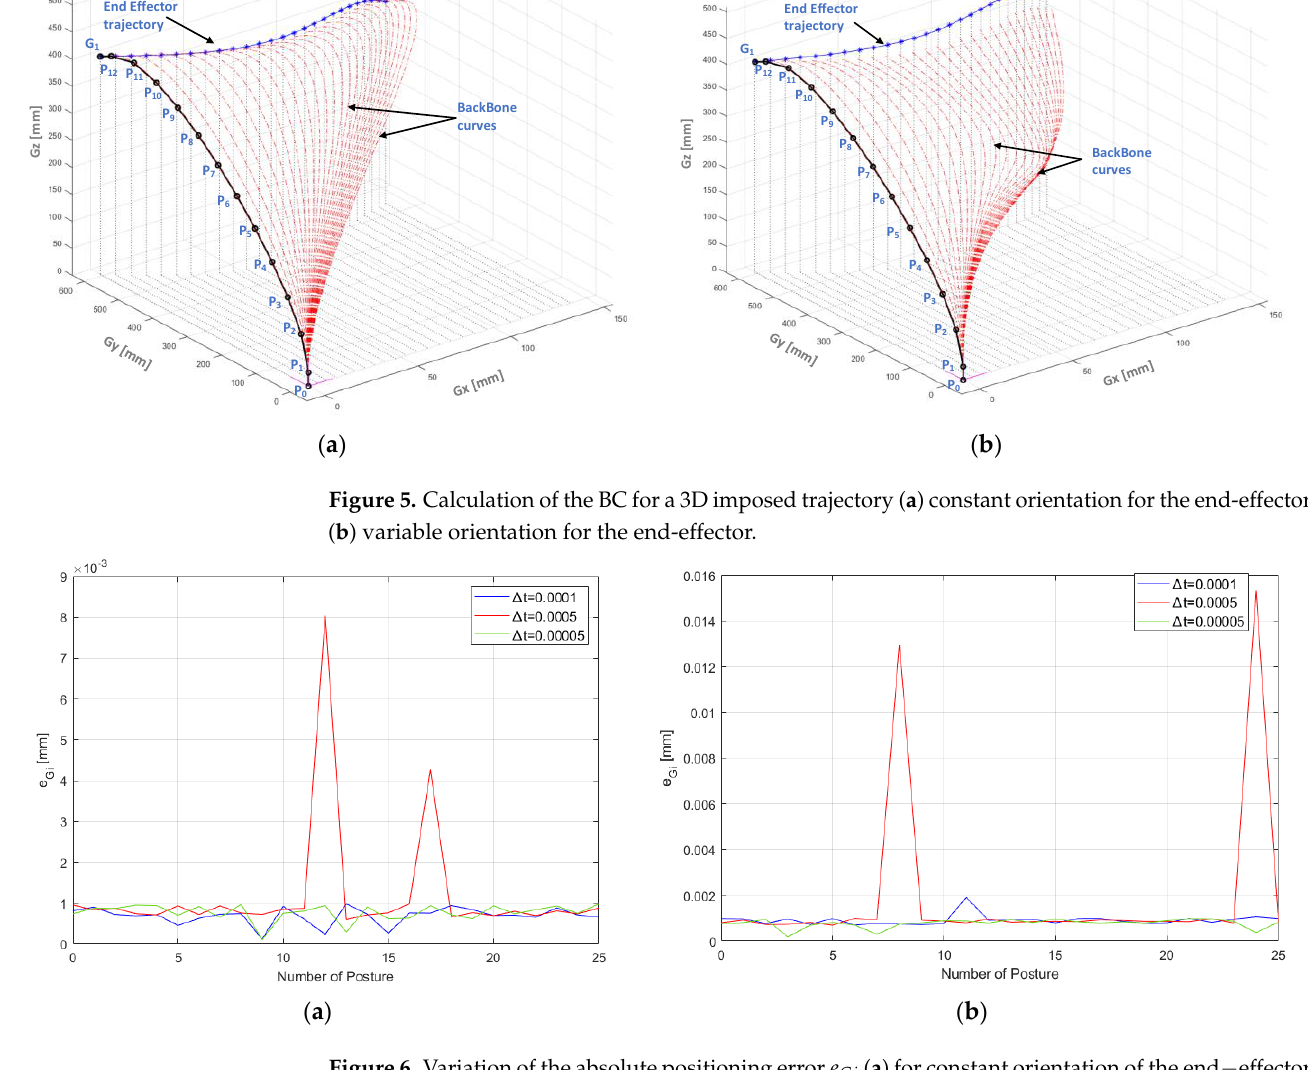
Figure 6. Variation of the absolute positioning error 𝑒 𝐺𝑖 ( a ) for constant orientation of the end − effector ( b ) for variable orientation of the end − effector.